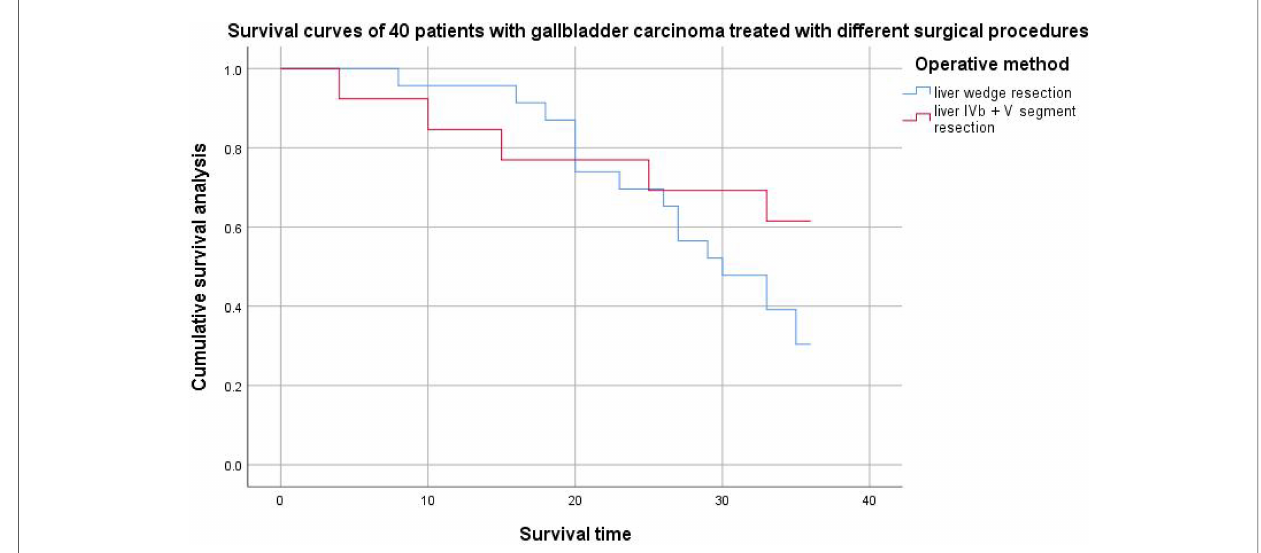
FIGURE 2. Survival of 40 patients gallbladder carcinoma treated with different surgical